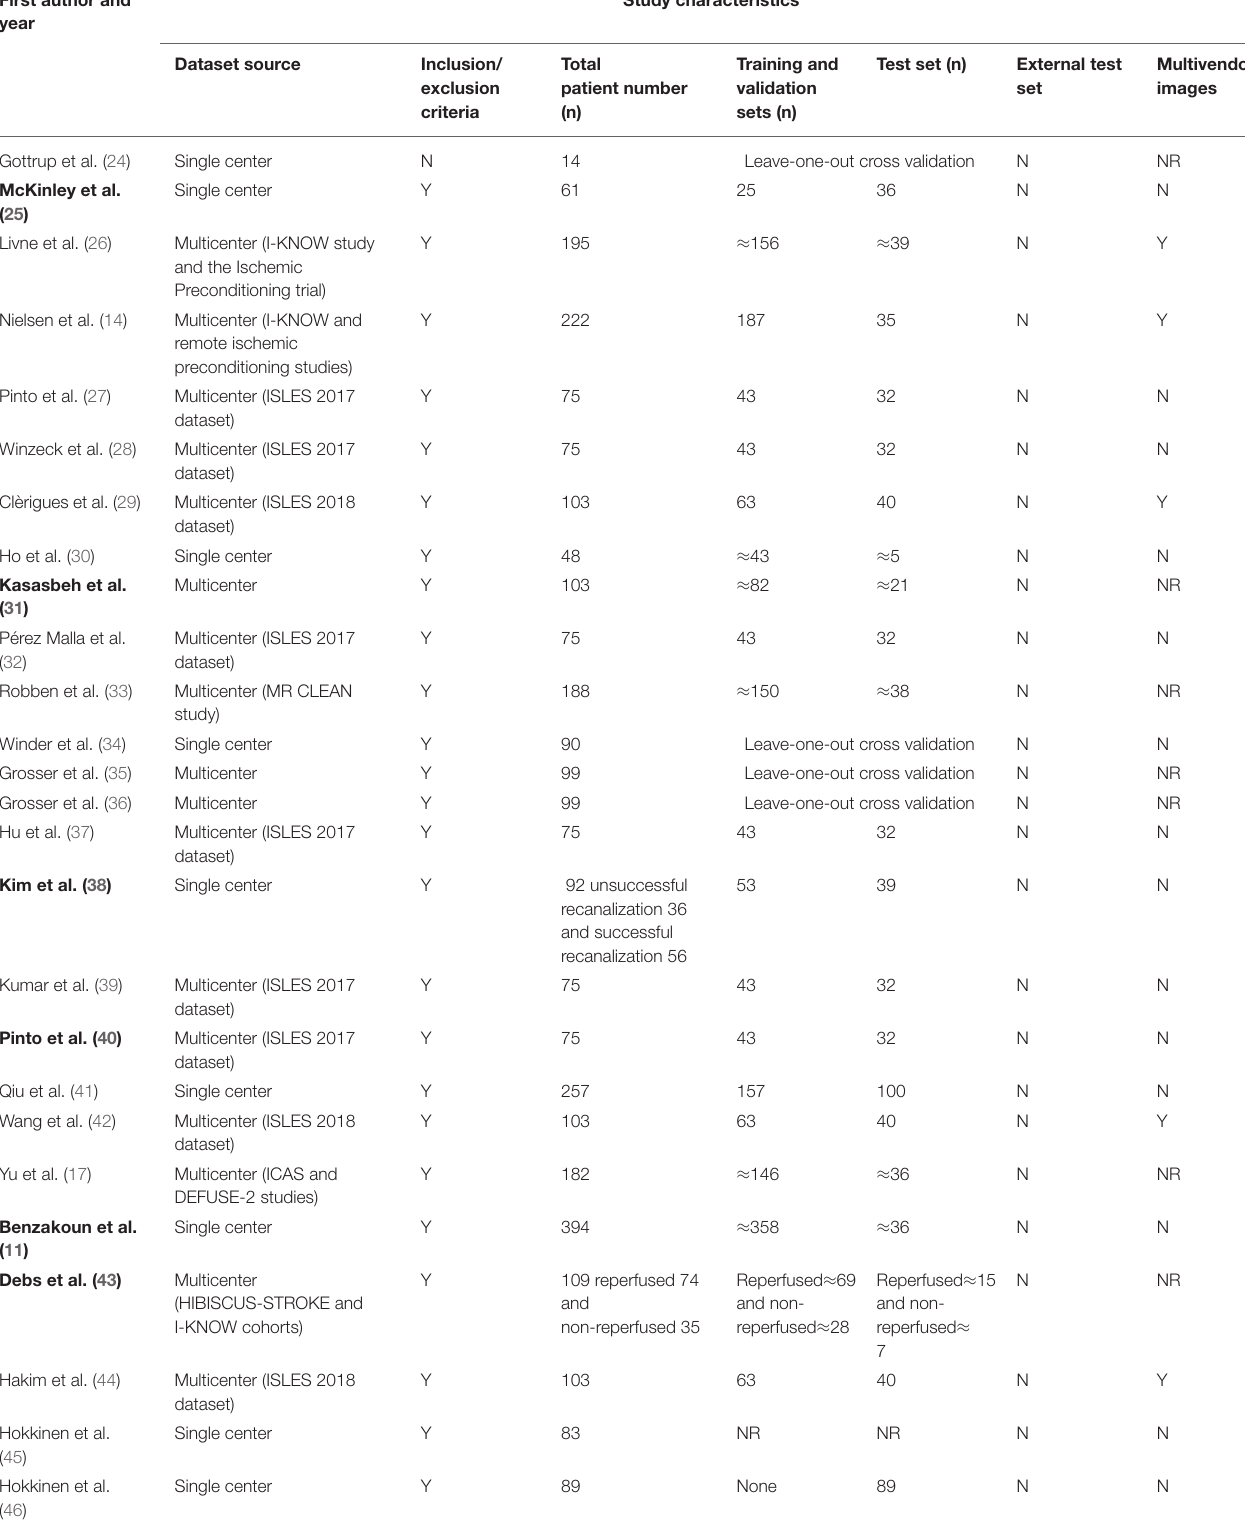
TABLE 1 | Study characteristics, model methodology, and predictive performance of the included